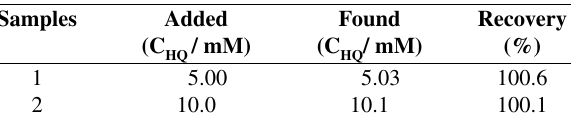
Table 3. Recoveries for determination of HQ in artificially conta- minated river water from Turkey. Samples